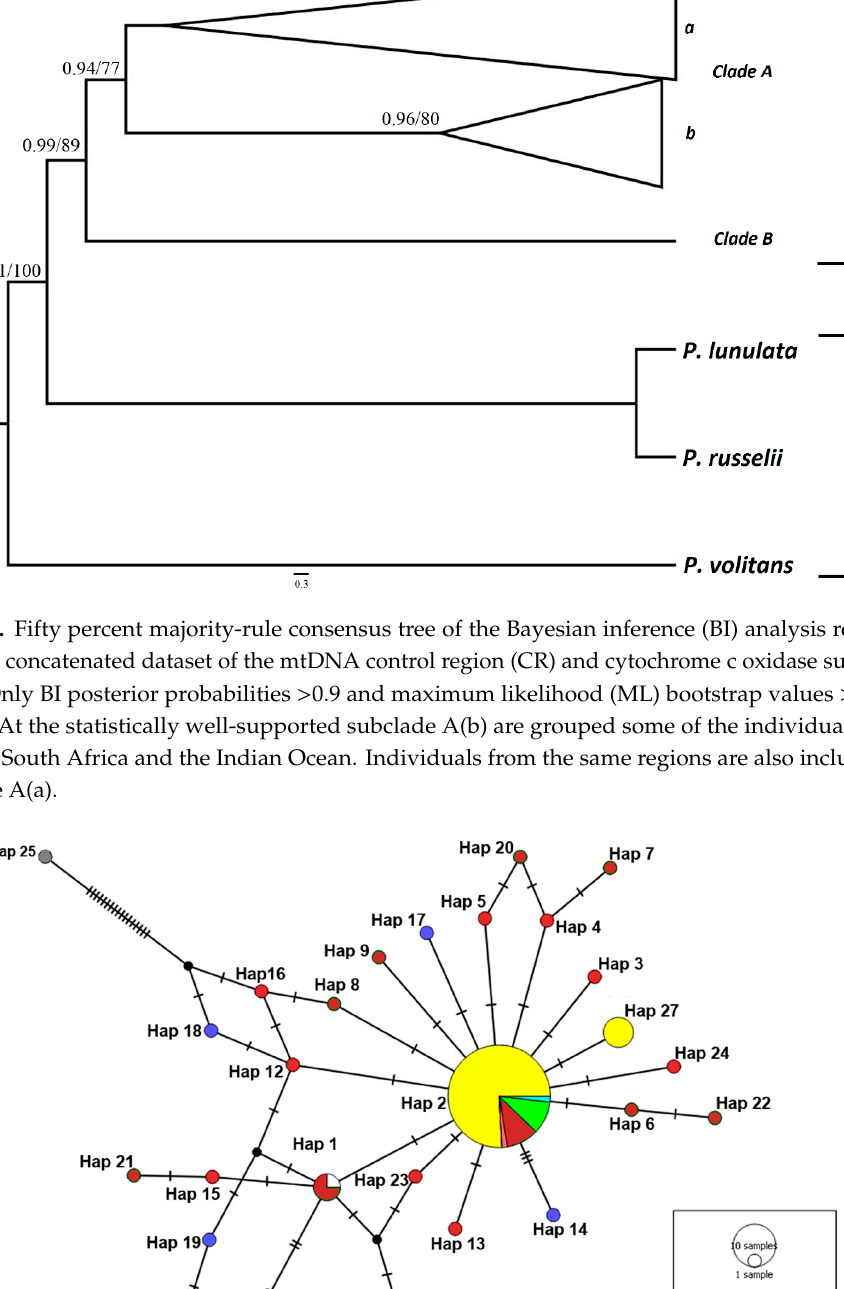
Figure 1. Localities of Pterois miles specimens included in our analyses. Colors correspond to Figures 3 and 4.